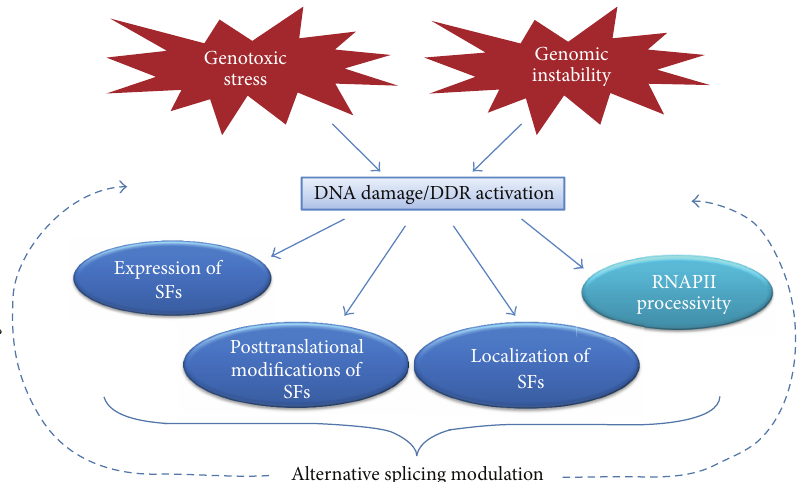
Figure 1: How the DDR can affect alternative splicing. The activation of the DDR can modify alternative splicing by affecting the expression, or by inducing posttranslational modifications of splicing factors (SFs), that may alter their intracellular localization and/or their activity. Moreover, also the elongation activity of RNA polymerase II (RNAPII) can be influenced by genotoxic stress, modifying in turn pre-mRNA